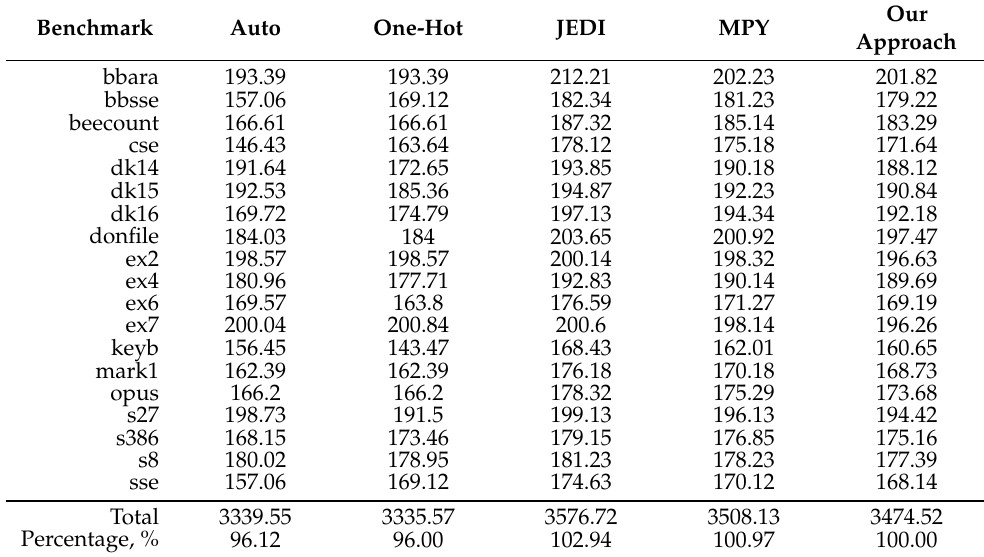
Table 15. Experimental results (the maximum operating frequency for BM2, MHz). Benchmark